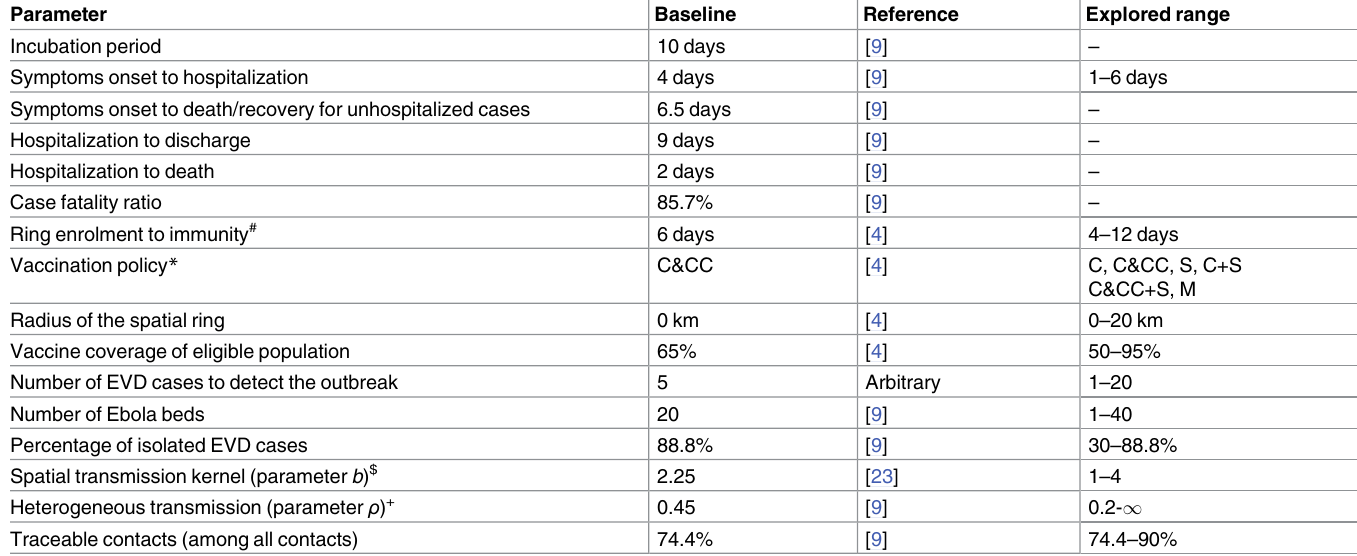
Table 1. Model parameter